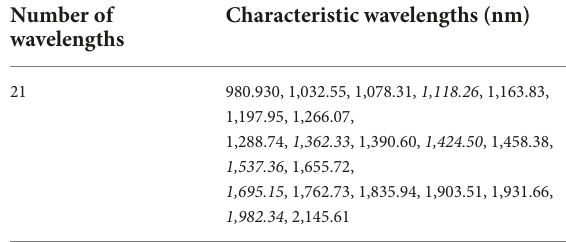
TABLE 2 List of 21 characteristic wavelengths. Number of wavelengths